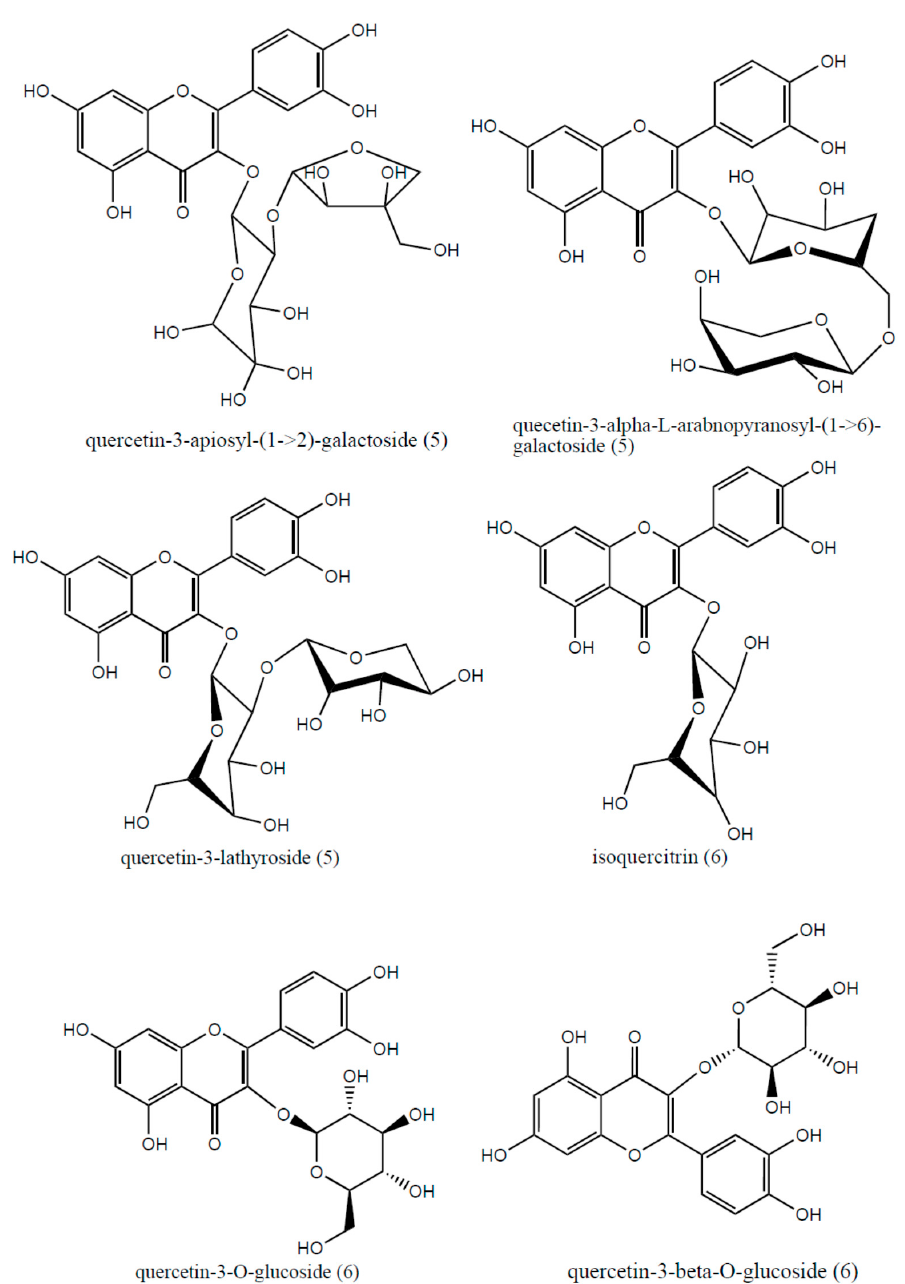
Figure 6. Chemical structure of possible isomers for the compounds 5 and 6 identified by HPLC-ESI-MS in hydroalcoholic extract from leaves of Himatanthus. drasticus .